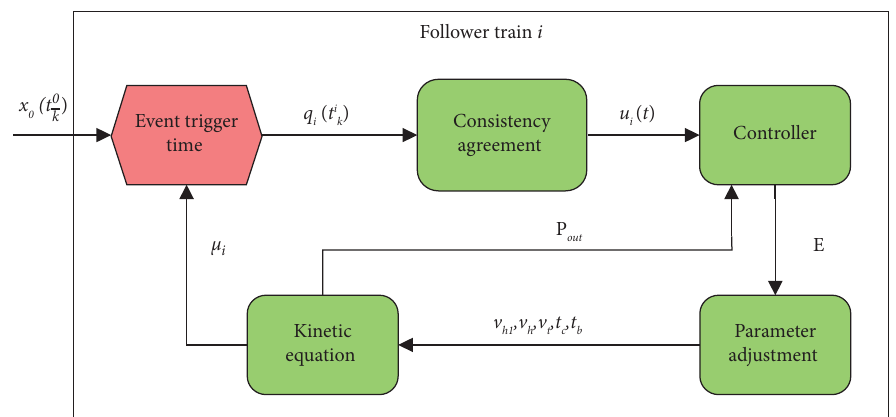
Figure 3: Control structure diagram of the follower